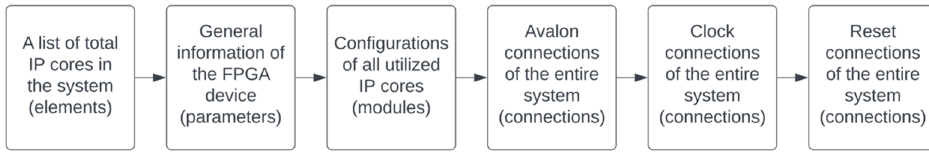
Figure 12. An abstract diagram of the information in a <.qsys > file.